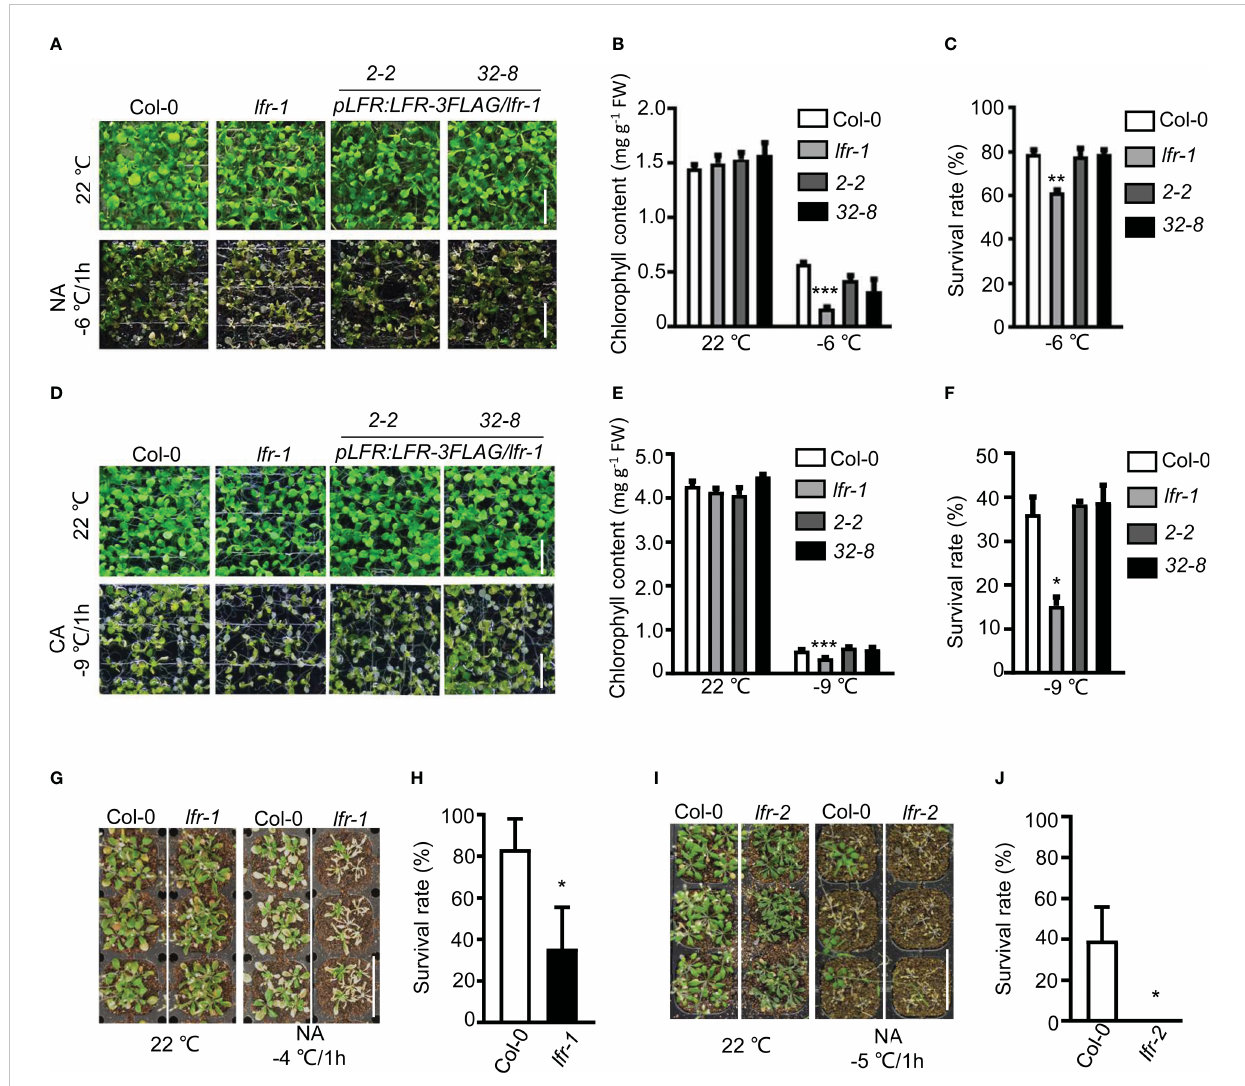
FIGURE 1 Phenotype analysis of lfr mutant plants and transgenic rescue lines exposed to freezing stress. (A, D) The lfr-1 mutant is sensitive to freezing stress. Representative pictures of 10-day-old seedlings of Col-0, lfr-1 , and two complementary lines of pLFR : LFR -3 FLAG / lfr-1 (2-2 and 32-8) were subjected to freezing stress under NA (A) or CA (D) conditions. After freezing stress, seedlings were incubated at 4°C overnight in the dark and then were allowed to recover for 2 days at 22°C. Scale bar=1 cm. (B, E) The chlorophyll contents of Col-0, lfr-1 , and two complemented transgenic lines (2-2 and 32-8) treated with or without freezing stress under NA (B) and CA (E) conditions are shown. (C, F) The survival rates of Col-0, lfr-1 , and two complemented transgenic lines (2-2 and 32-8) after being subjected to freezing stress under NA (C) or CA (F) conditions are shown. (G) and (I) Representative examples of the reduced freezing tolerance observed in soil-grown lfr-1 (G) and lfr-2 (I) plants. Scale bar=2 cm. (H, J) The survival rates of soil-grown Col-0 and lfr-1 (H) and Col-0 and lfr-2 (J) plants that were subjected to freezing stress (-4 or -5°C) and then allowed to recover are shown. Error bars indicate the SD of three biological replicates. Statistically signi fi cant differences are indicated by asterisks (*P<0.05, **P < 0.01, and ***P < 0.001; Student ’ s t